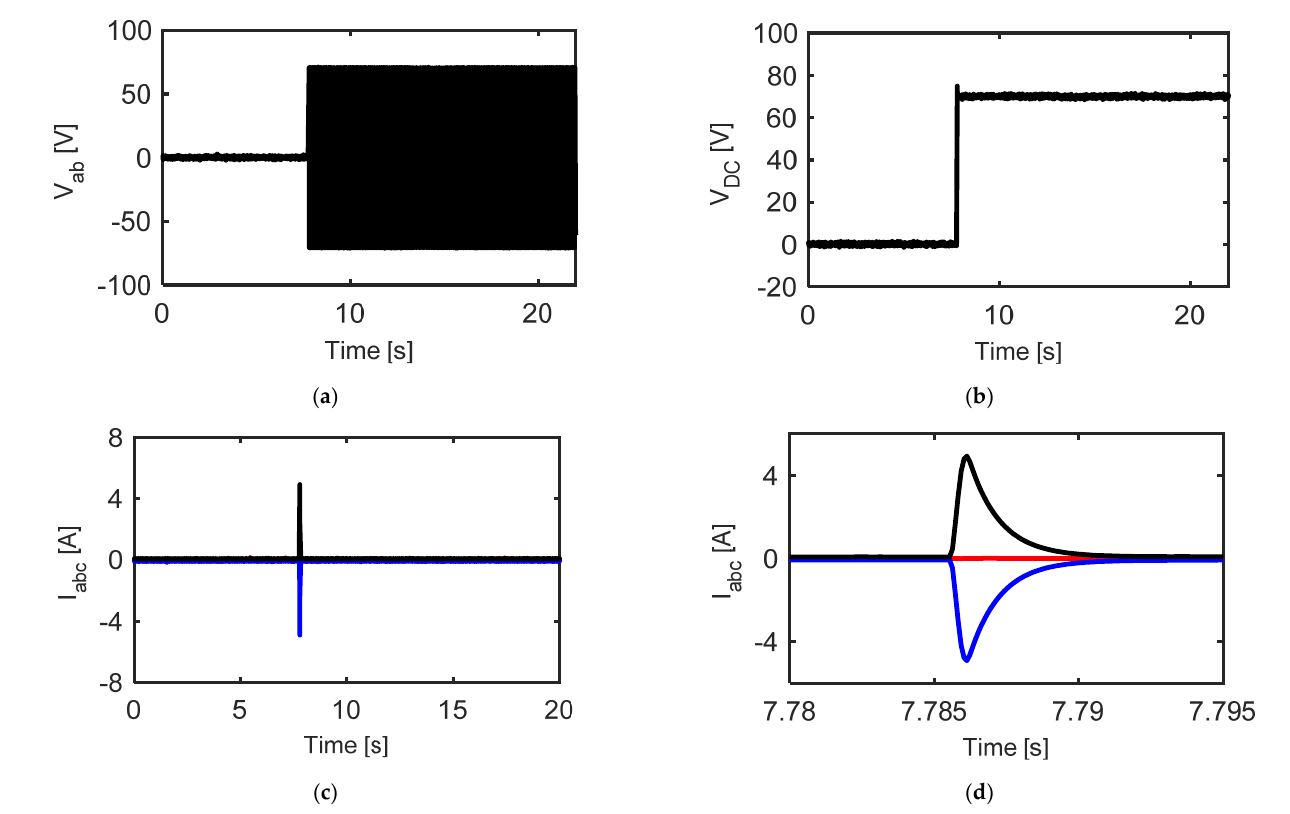
Figure 10. Experimental testing of the clamping circuit at start-up without operating the PWM of the rectifier and charging using step-input-line voltage V ab ( a ) Line-input voltage V ab , ( b ) DC-link voltage, ( c ) input current for MC and ( d ) zoom-in view of the input current at start-up.